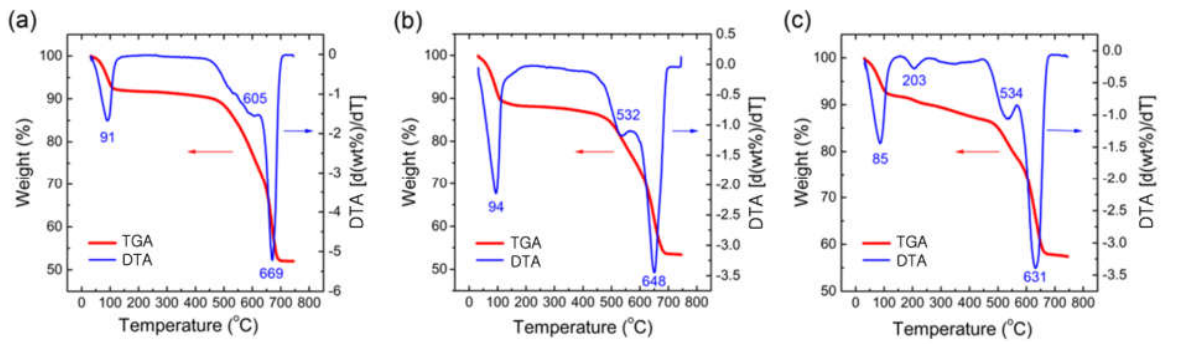
Figure 1. Thermogravimetric analysis (TGA) and differential thermal analysis (DTA) curves for the Ba 1.3 Ca 0.7 SiO 4 samples after burning at 550 °C, at a heating rate of 10 °C/min under a N 2 flow of 80 cm 3 /min: ( a ) metal nitrate:urea = 1:0.75, ( b ) metal nitrate:urea = 1:1.15, and ( c ) metal nitrate:urea =